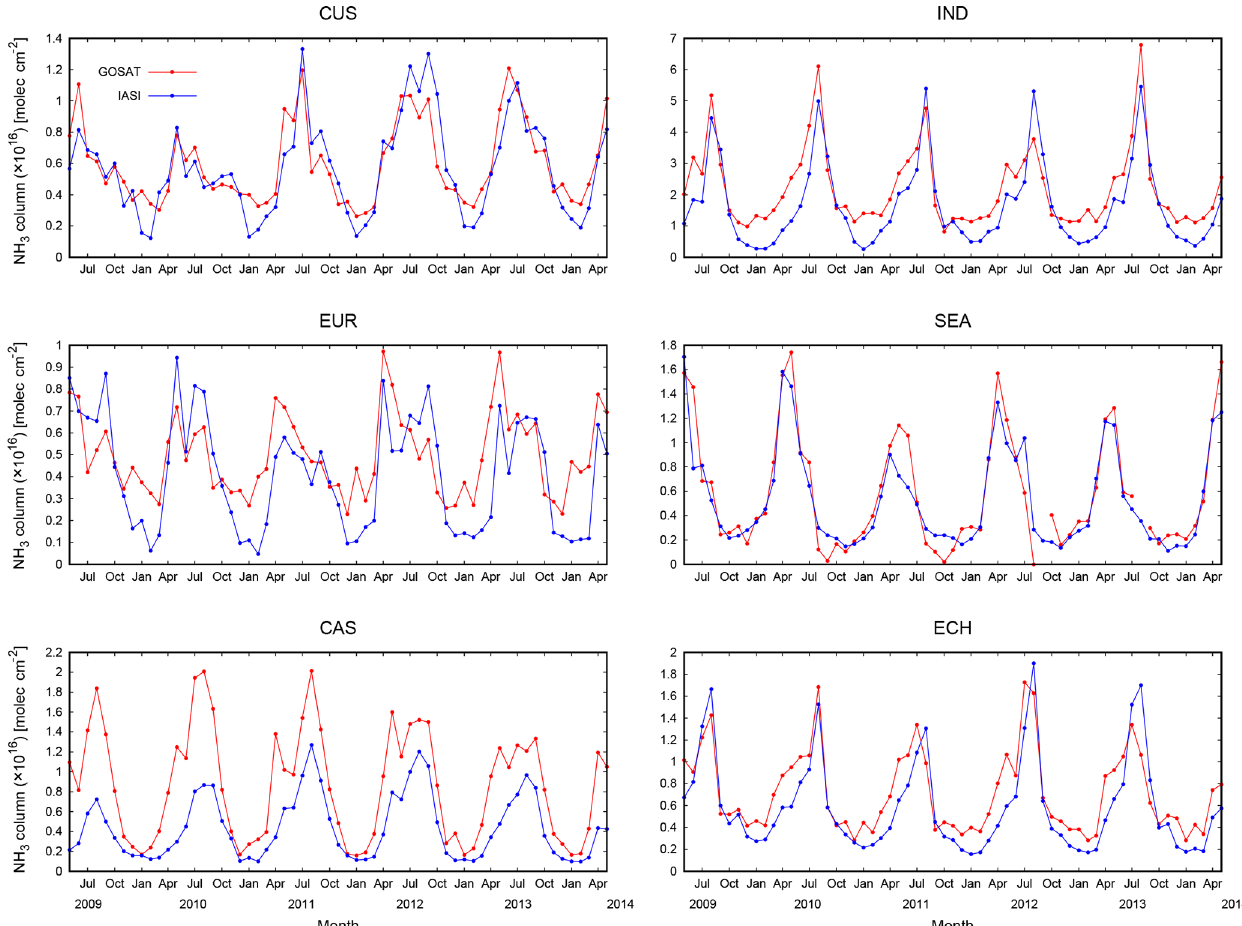
Figure 9. Time series of the monthly averaged ammonia column amounts from GOSAT (red) and IASI (blue) from May 2009 to May 2014 in the agricultural emission areas noted in Table